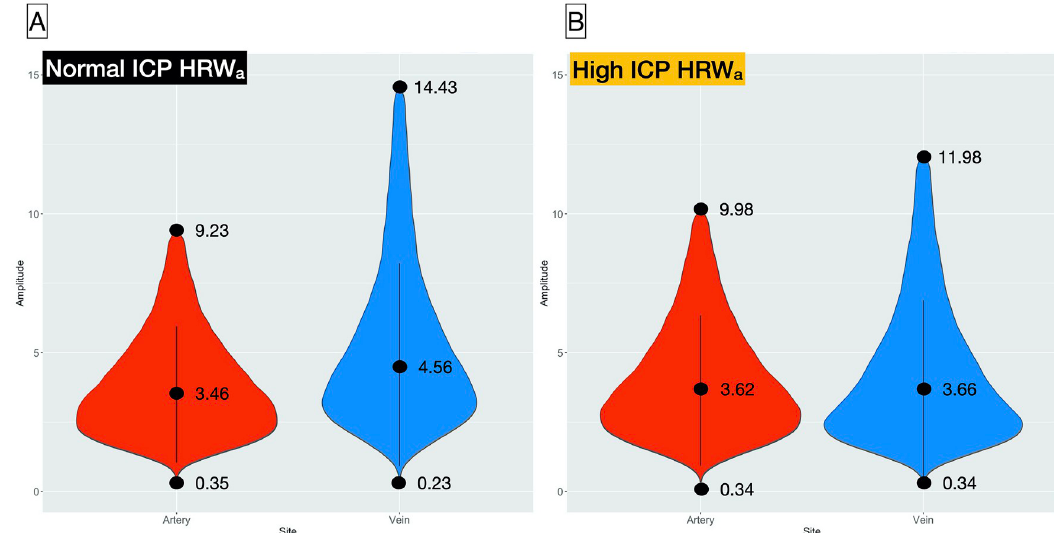
Fig 2. Violin plot of the distribution of the HRW a . A) Study group with normal intracranial pressure ICP n (ICP � 25cm water) and B) high intracranial pressure ICP h (ICP > 25cm water). The median ± IQR (line and center dot) and range (end dots) are highlighted for each group.